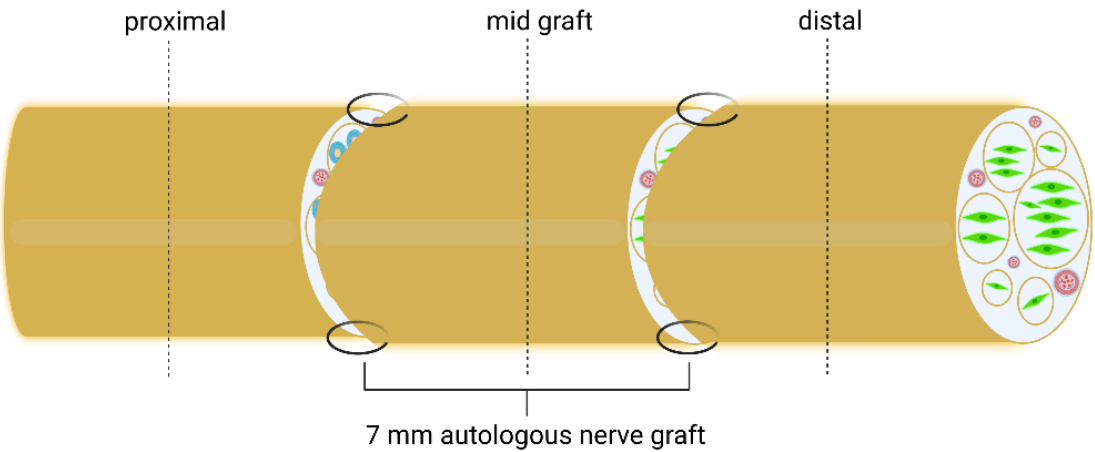
Figure 7. Schematic of the repaired median nerve with histological sections and their respective localization indicated as proximal, start graft, mid graft and distal. Dotted lines indicate histological cutting planes [49] .